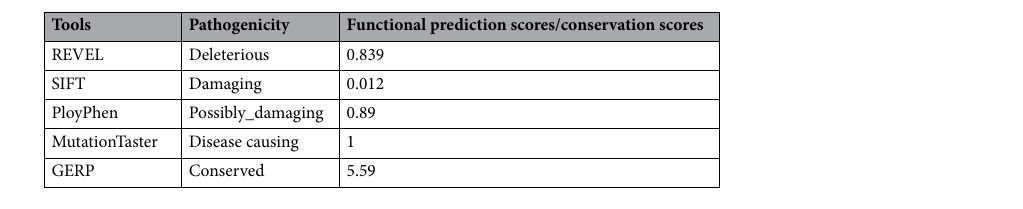
Table 2. Pathogenicity assessment in silico of WFS1 c.2421C>G